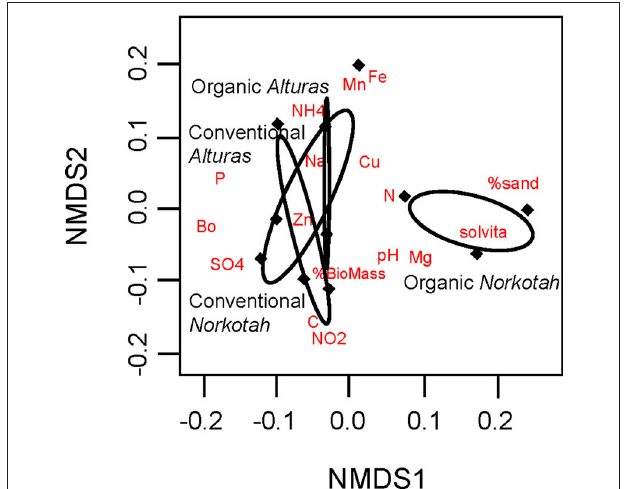
FIGURE 3 | Physical and chemical profiles of soil displayed on two non-metric multidimensional scaled axes. Ellipses indicate clustering of our four treatment groups which consisted of two cropping system treatments (conventional and organic) and two potato varieties ( Norkotah and Alturas ). Red labels indicate the locations of soil characteristics that distinguish clusters.